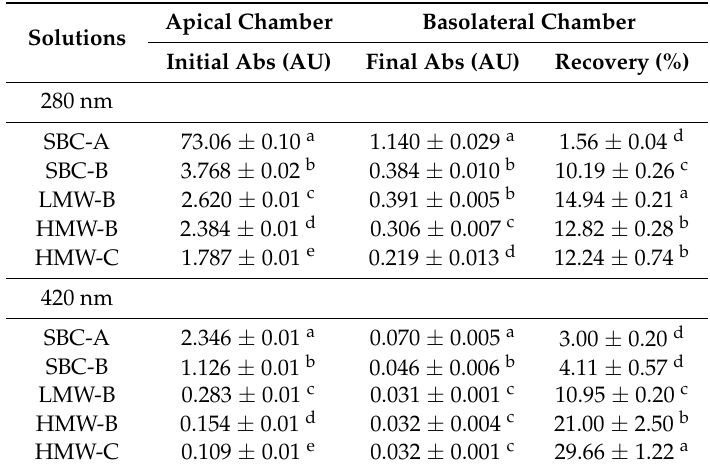
AU: arbitrary units. Values are mean ± SE ( n = 3). Different letters in each column indicate significant differences between samples ( p < 0.05). SBC-A: soluble bread crust fraction dilution 1:3 ( v / v ); SBC-B: soluble bread crust fraction dilution 1:9 ( v / v ); LMW-B: soluble LMW fraction naturally present in SBC-B; HMW-B: soluble HMW fraction naturally present in SBC-B. HMW-C: soluble HMW fraction in the same amount of